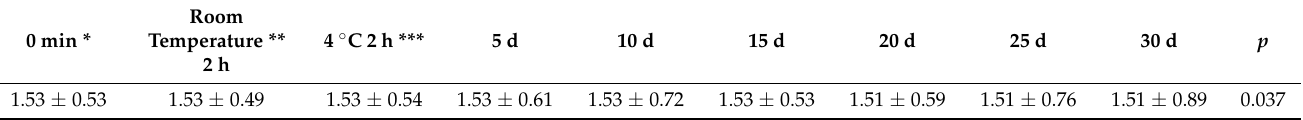
Table 5. Effects of different storage conditions on salivary glucose. (Unit: mmol/L).